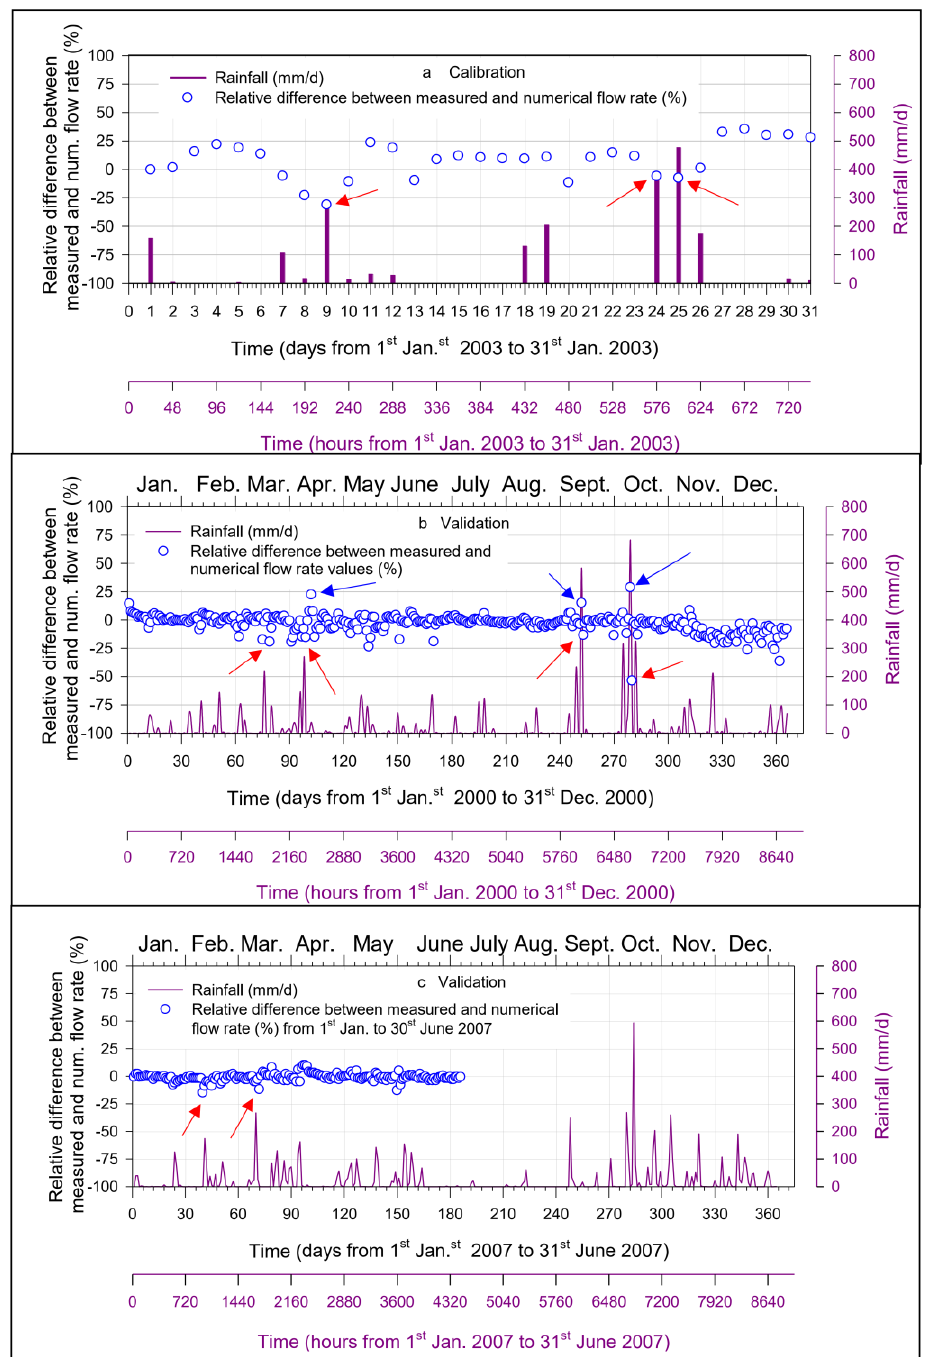
Figure 9. Relative Differences between measured river flow rate and predicted numerical flows data: RDMN (%); days and hours: ( a ) from 1 January 2003 to 31 January 2003 (calibration); ( b ) from 1 January 2000 to 31 December 2000 (validation); ( c ) from 1 January 2007 to 30 June 2007 (validation).